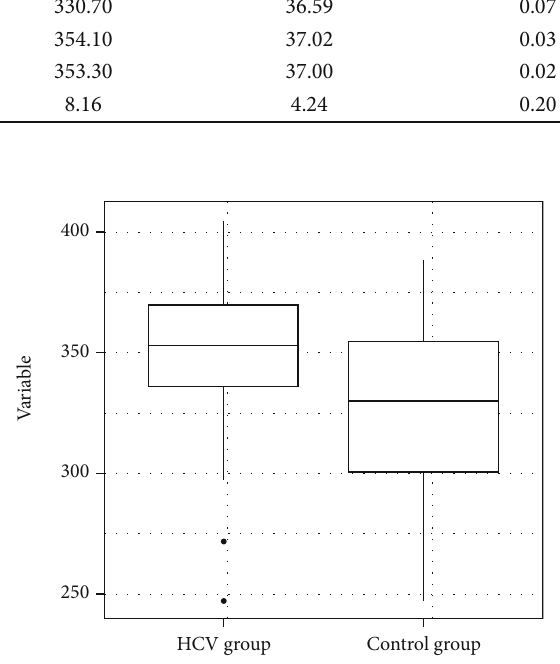
Figure 6: Distribution of variable cognitive evoked potentials (P300) ( Z score).